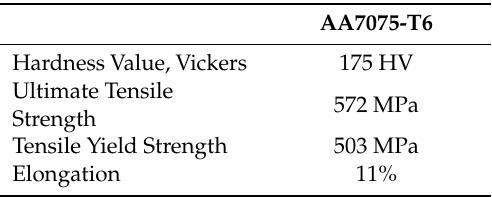
Table 1. Properties of